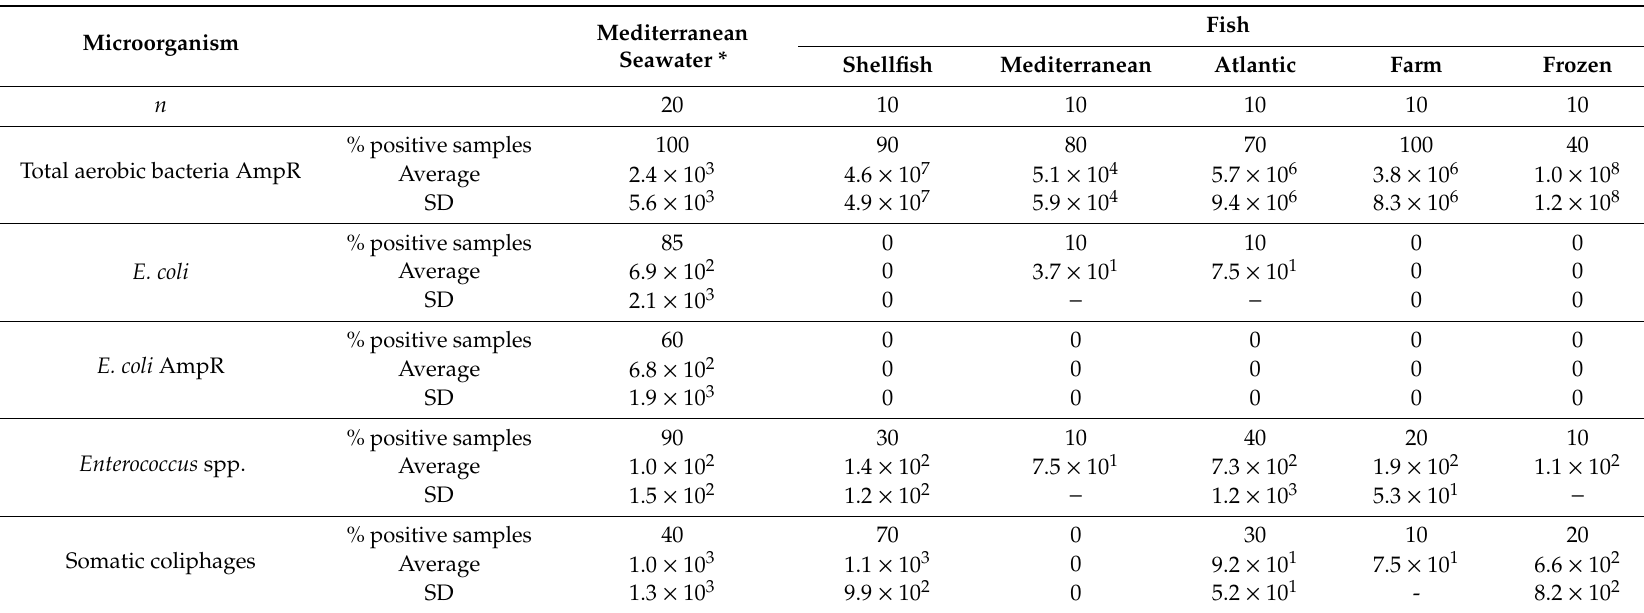
Table 1. Bacterial (CFU / 25 g) and viral (PFU / 25 g) indicators in Mediterranean seawater, fish and shellfish samples. -; only one positive sample, no SD. Microorganism